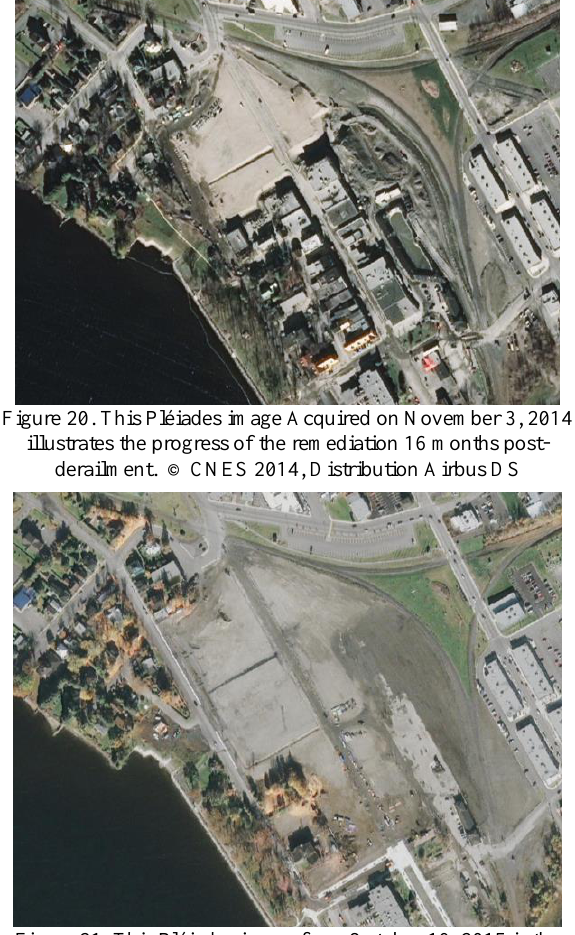
Figure 21. This Pléiades image from October 19, 2015 is the most recent optical image of the disaster site, note the number of newly removed